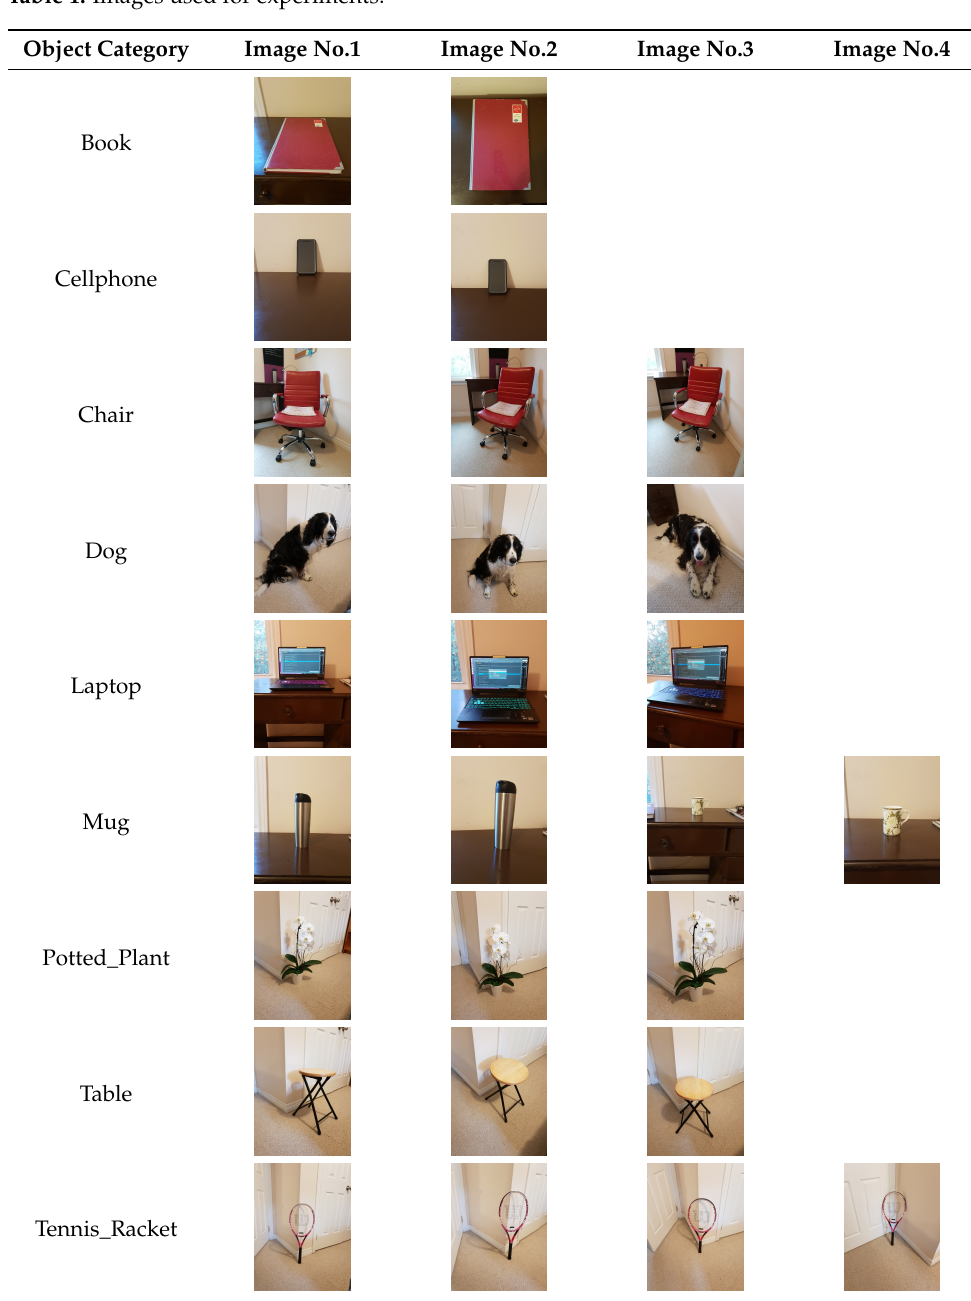
Table 1. Images used for